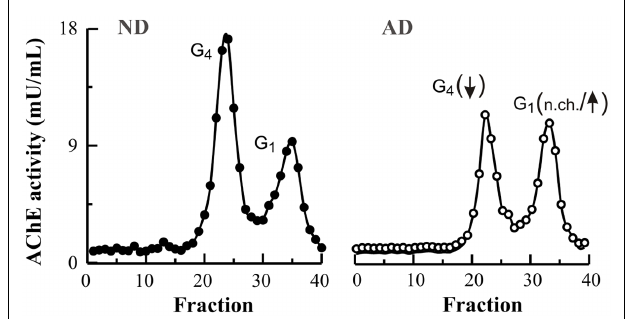
FIGURE 1 |Tetrameric and monomericAChE molecular forms are differentially affected in theAlzheimer’s brain. Human frontal cortex from non-demented individuals (ND; closed circles) and Alzheimer’s patients (AD; open circles) were extracted in aTris–saline buffer containing proteinases inhibitors and 1% (w/v)Triton X-100. Molecular weight forms of AChE were analyzed by ultracentrifugation at 150,000 × g in a continuous sucrose gradient (5–20% w/v), containing 0.5% (w/v)Triton X-100, for 18h at 4˚C as previously described (Sáez-Valero et al., 1999).Tetramers (G 4 ) and monomers (G 1 ) AChE forms were identified by their coefficient of sedimentation.The proportion of G 4 forms in AD is particularly depleted whereas the minor G 1 species are mostly preserved (no change; n.ch.) or even slightly increased.